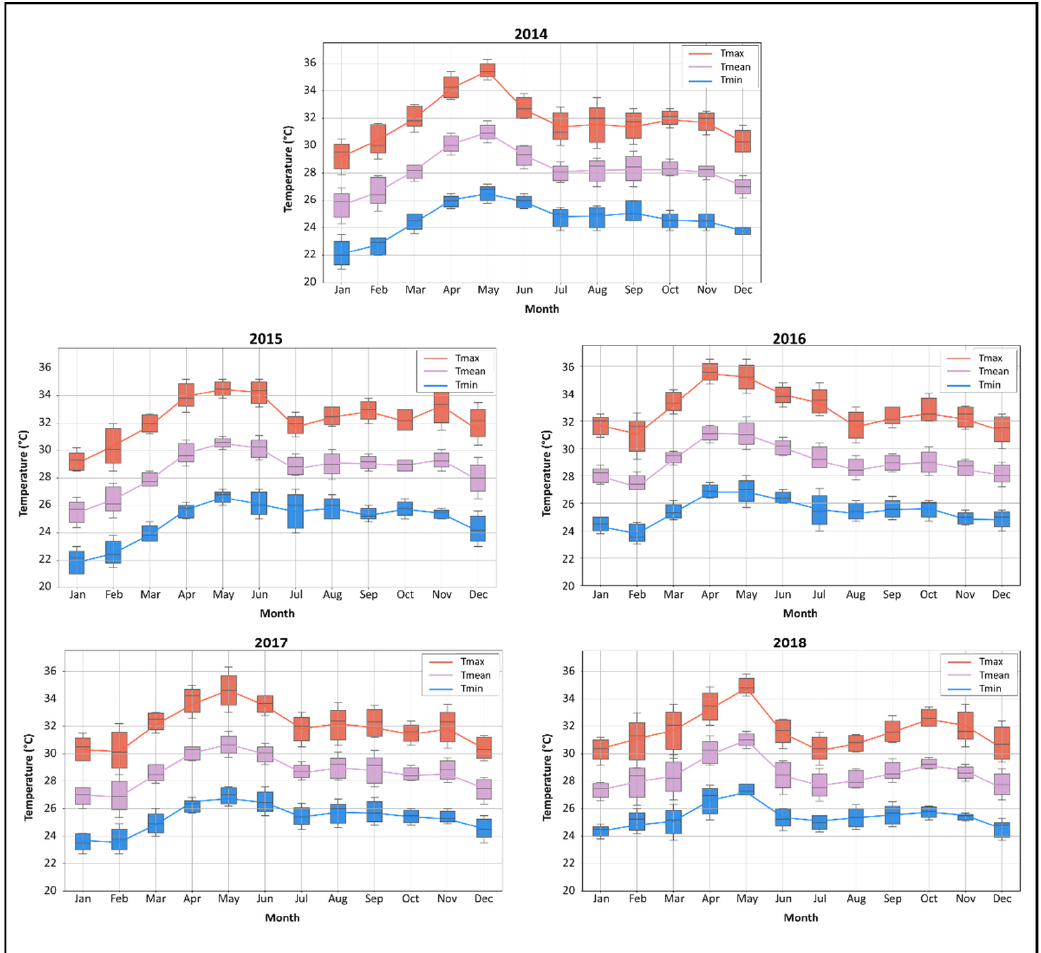
Figure 6. Monthly maximum (Tmax), mean (Tmean), and minimum (Tmin) air temperature trends from 2014 to 2018.